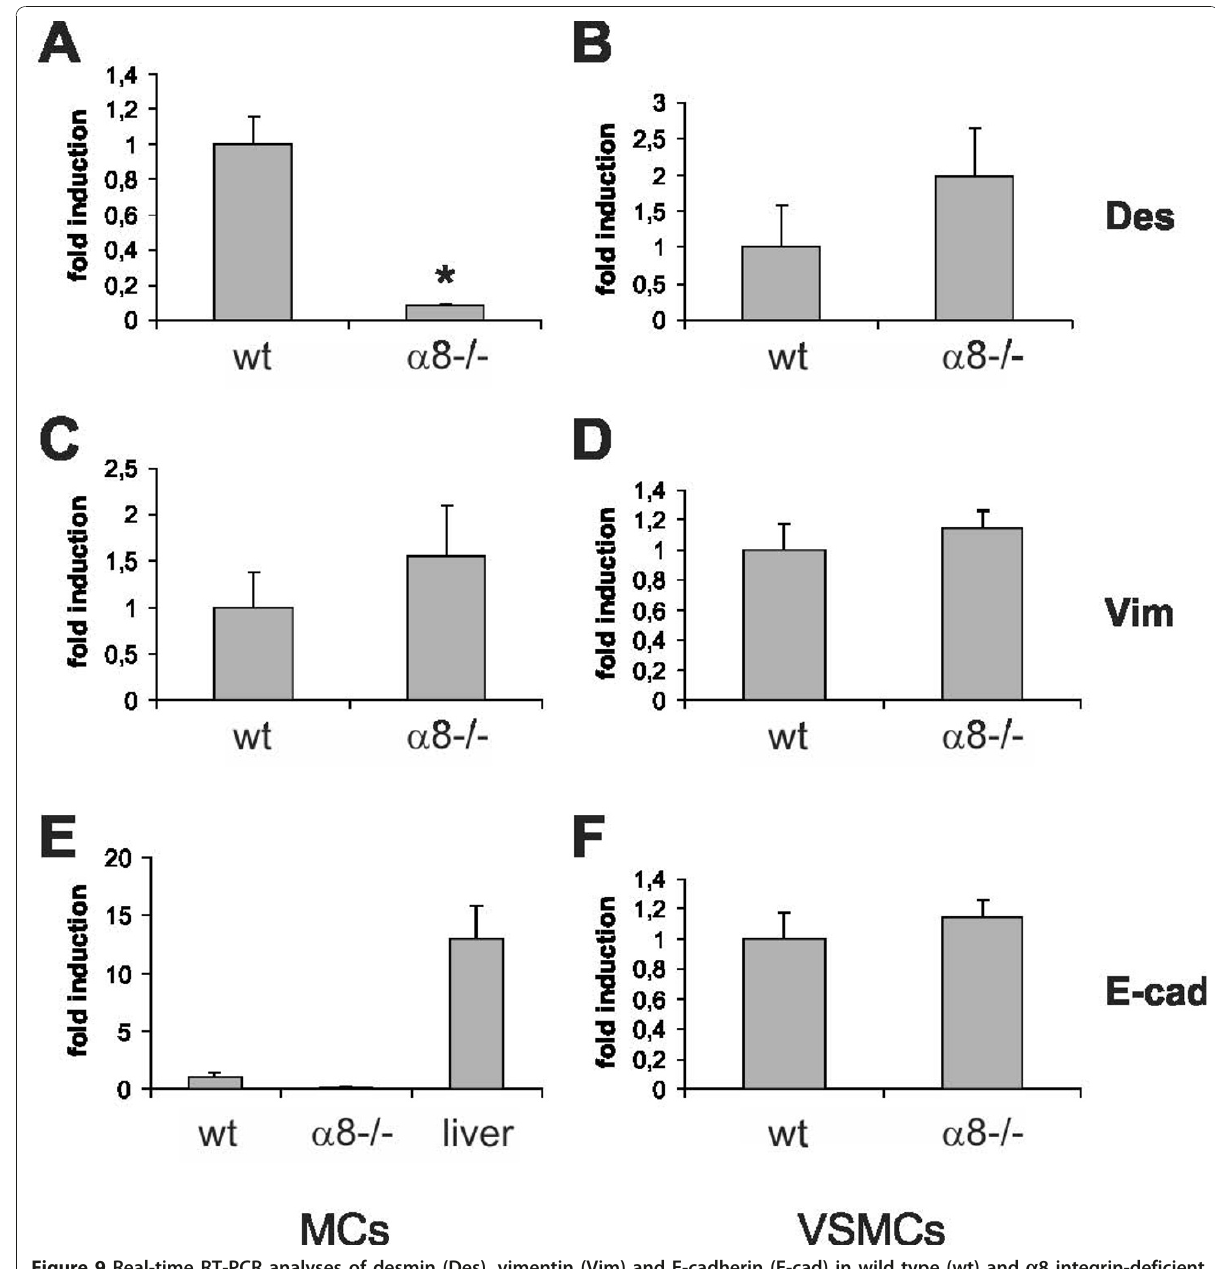
Figure 9 Real-time RT-PCR analyses of desmin (Des), vimentin (Vim) and E-cadherin (E-cad) in wild type (wt) and a 8 integrin-deficient ( a 8-/-) mesangial cells (MCs) and freshly isolated vascular smooth muscle cells (VSMCs) . For E-cadherin expression in MCs, a positive control (liver cells) was used. Results are representative for at least 3 similar experiments. Data are means ± sd. * p < 0.05 vs.